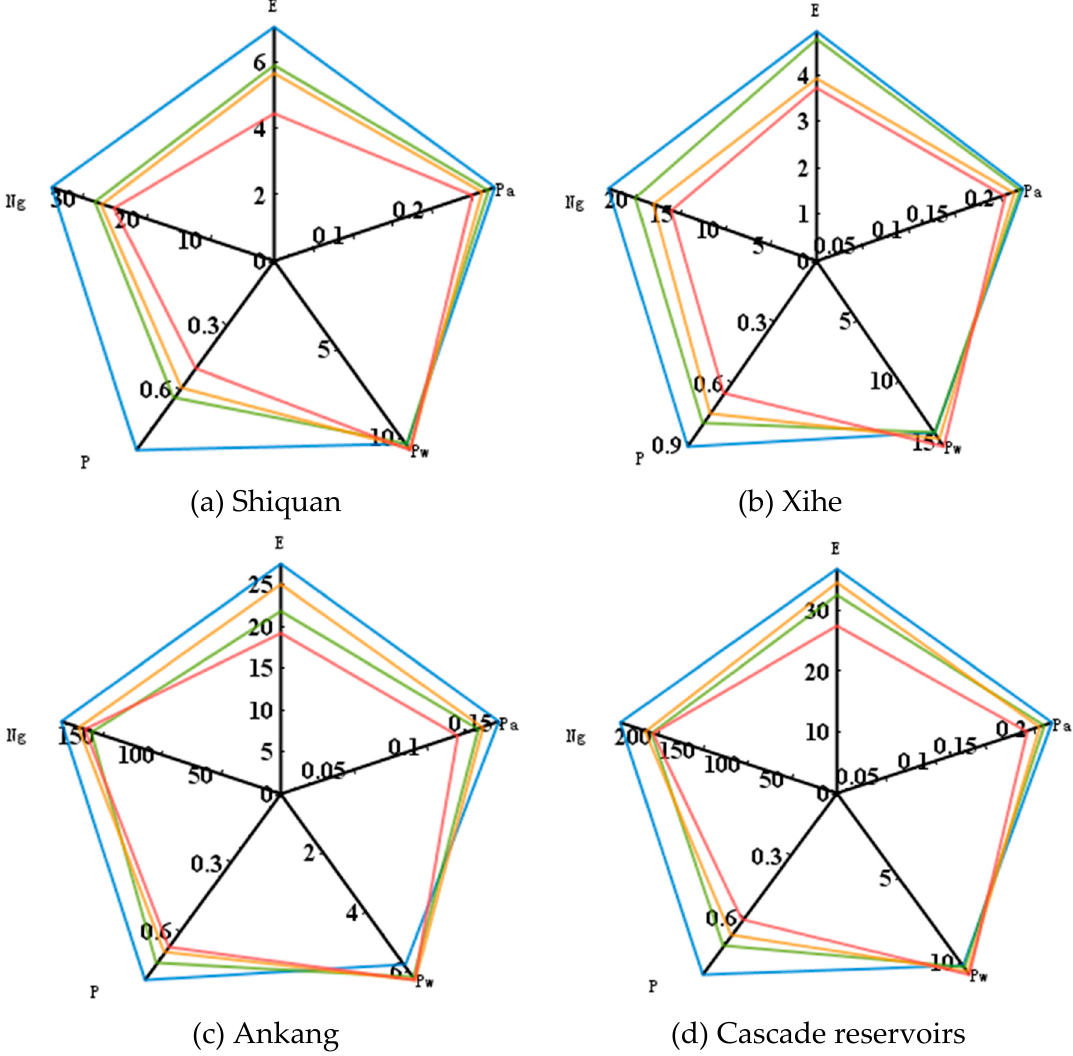
Figure 5. Operating parameters ( E , N g , P , P w , and P a ) of the hydropower stations in the conventional operation chart under the four schemes. The blue, green, yellow, and red curve are in turn scheme 1 to 4.